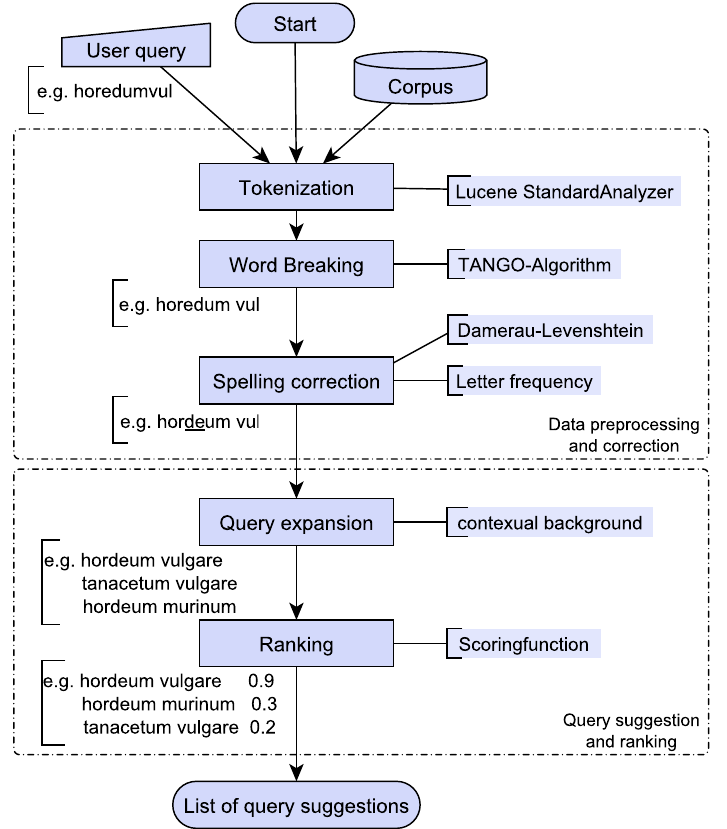
Figure 2: Workflow of a query expansion divided into the two steps of data processing and query suggestion. The example is based on possible hits for the request horedumvul